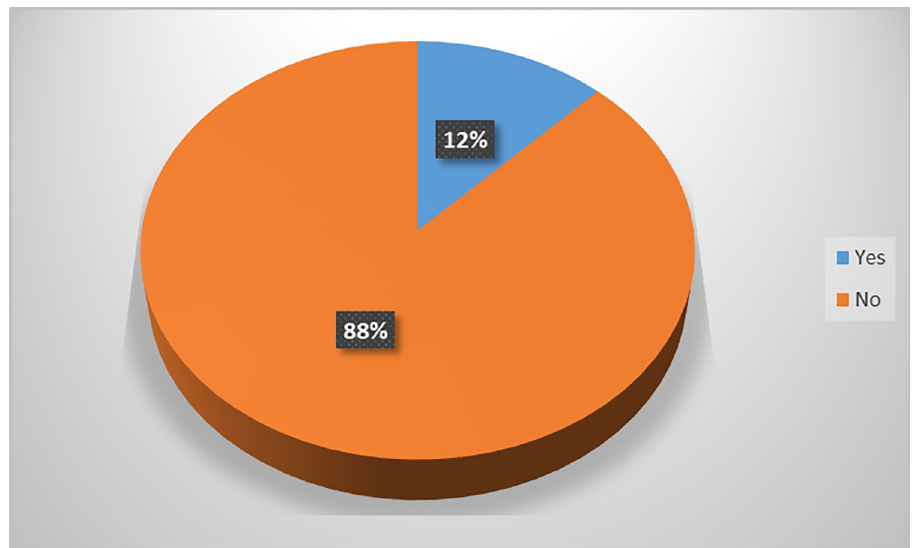
Fig 3. Magnitude of stillbirth of the study participant (n = 980) at Hossana town public health facilities, SNNPR, Ethiopia July 2017 June 2018.